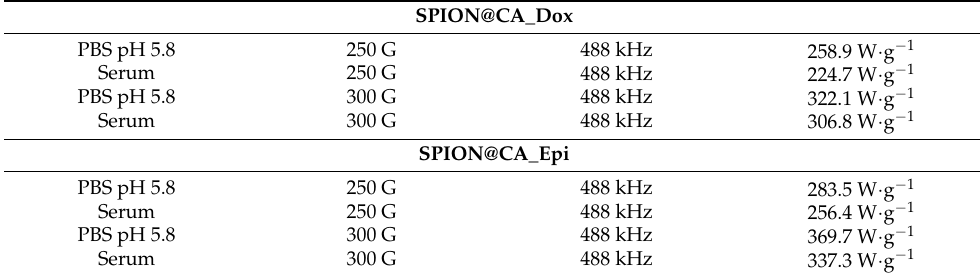
Table 1. Specific absorption rate (SAR) values for SPION@CA@Dox and SPION@CA_Epi hybrids.